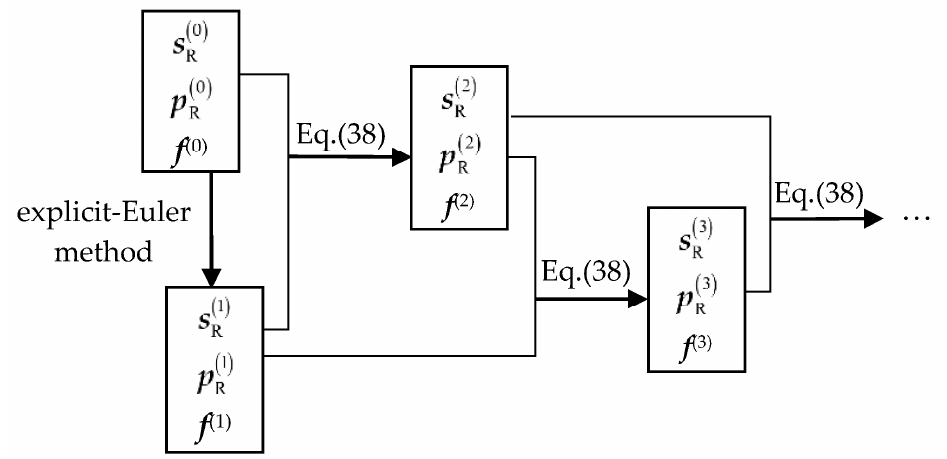
Figure 5. The basic structure of recursive expressions about generalized coordinates s R and general- ized momentum p R display.